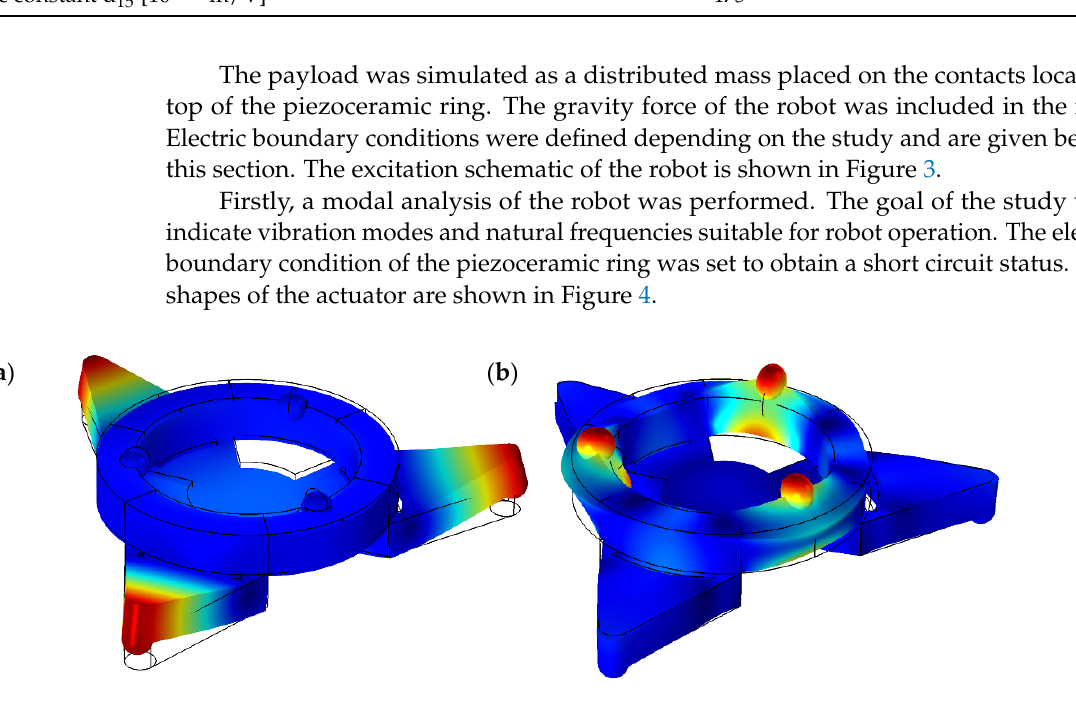
Figure 4. Modal shapes of the piezoelectric robot; ( a )—the first bending mode of trapezoidal cantilevers at 13.79 kHz; ( b )—the radial mode of the piezoelectric ring at 95.75 kHz.